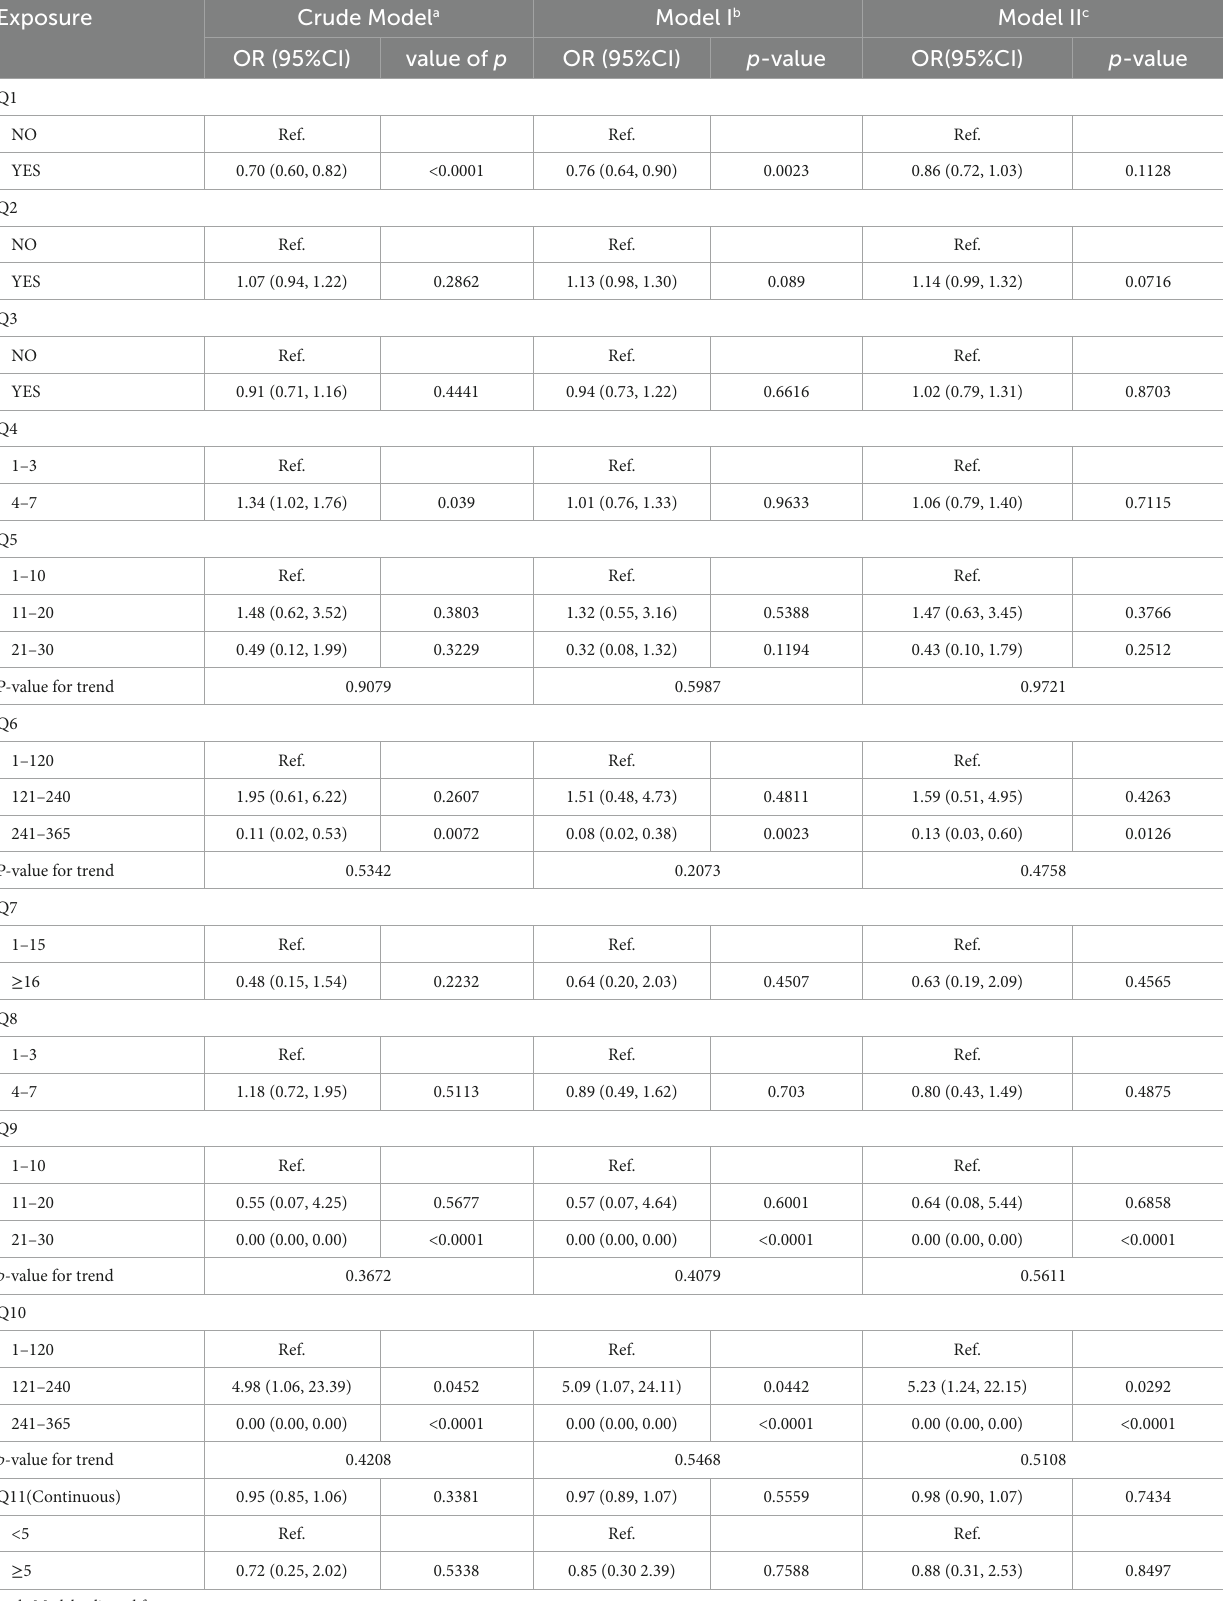
TABLE 2 Association between alcohol consumption and kidney